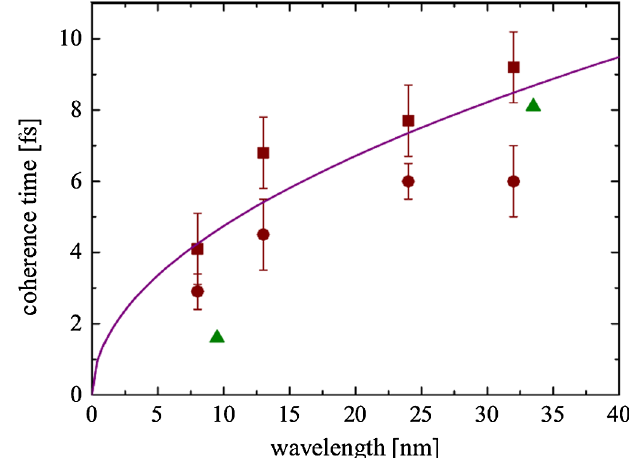
FIG. 6. Dependence of the coherence times on the wavelength. (HWHM); red squares: rms value Red dots: present results for (cid:2) c of the data; green triangles: measurements (rms) from Ref. [15]. The line is fitted according to Eq. (22).